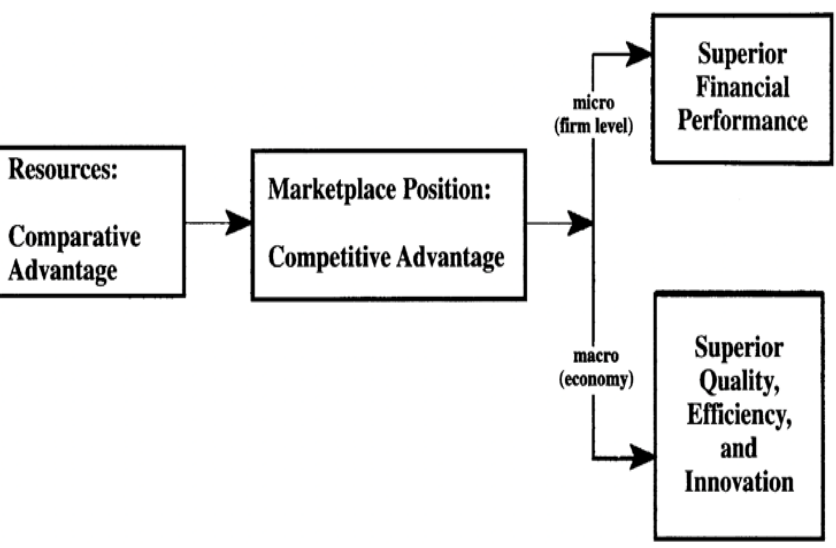
Figure 1. The Comparative Advantage Theory of Competition (Source: Hunt and Morgan 1995).